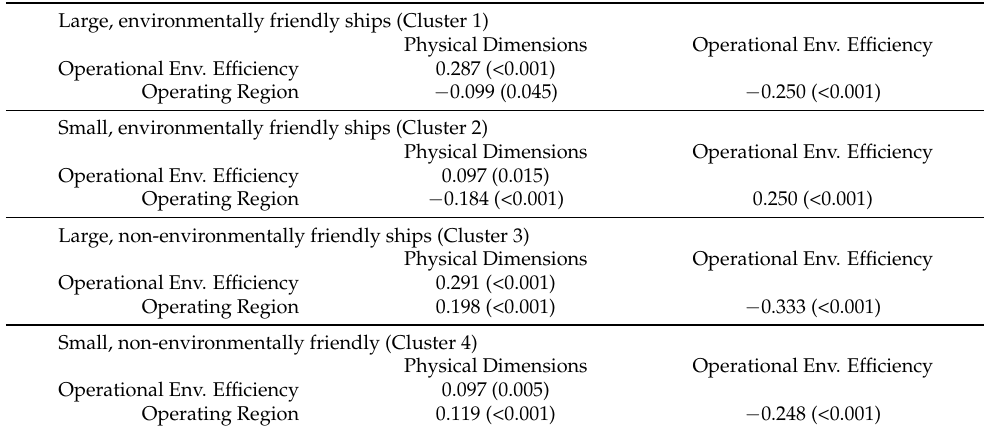
Table 3. The Pearson correlation coefficients and their corresponding p-values (in parentheses) for all the possible pairs of PCs in each cluster.